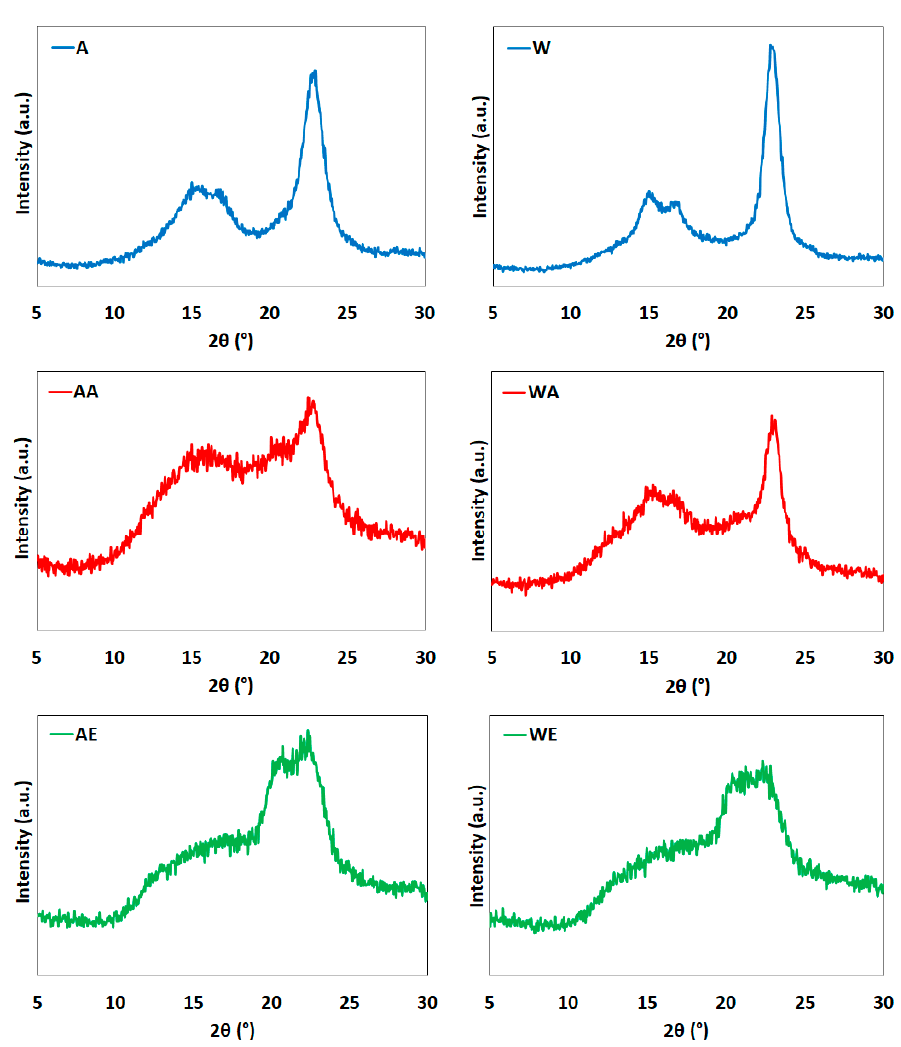
Figure 5. XRD patterns of ( A ) enzyme-pretreated Avicel cellulose, ( AA ) enzyme-pretreated Avicel cellulose treated with AmimCl, ( AE ) enzyme-pretreated Avicel cellulose treated with EmimOAc, ( W ) enzyme-pretreated Whatman cellulose, ( WA ) enzyme-pretreated Whatman cellulose treated with AmimCl, and ( WE ) enzyme-pretreated Whatman cellulose treated with EmimOAc. The diffractograms of cellulose after enzymatic hydrolysis (Avicel and Whatman) showed peaks characteristic of cellulose I at 2 θ = 15° (plane 1–10), 17° (plane 110), and 22.7° (plane 200) [71]. Additionally, these maxima were observed for the enzyme-